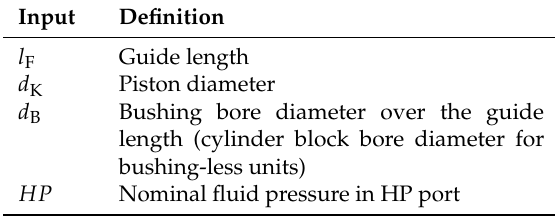
Figure 8. TPGA input overview. Table 1. Most critical common